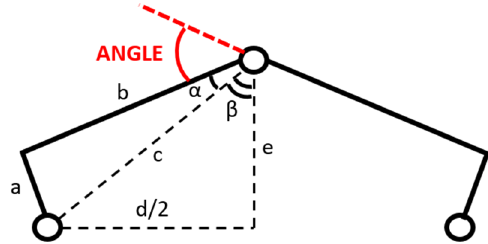
Figure 14. Angle of interest calculation.